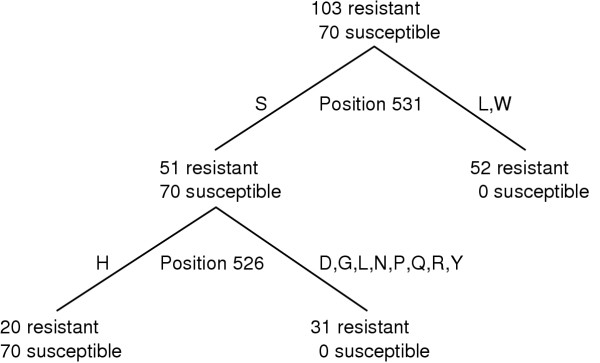
Cross-validated pruned classification tree for rifampin susceptibility and resistance based on amino acid sequence data from positions 511–533 of the β subunit of RNA polymerase of Mycobacterium tuberculosis. The numbers of observations in each class, susceptible or resistant, are given for each node.